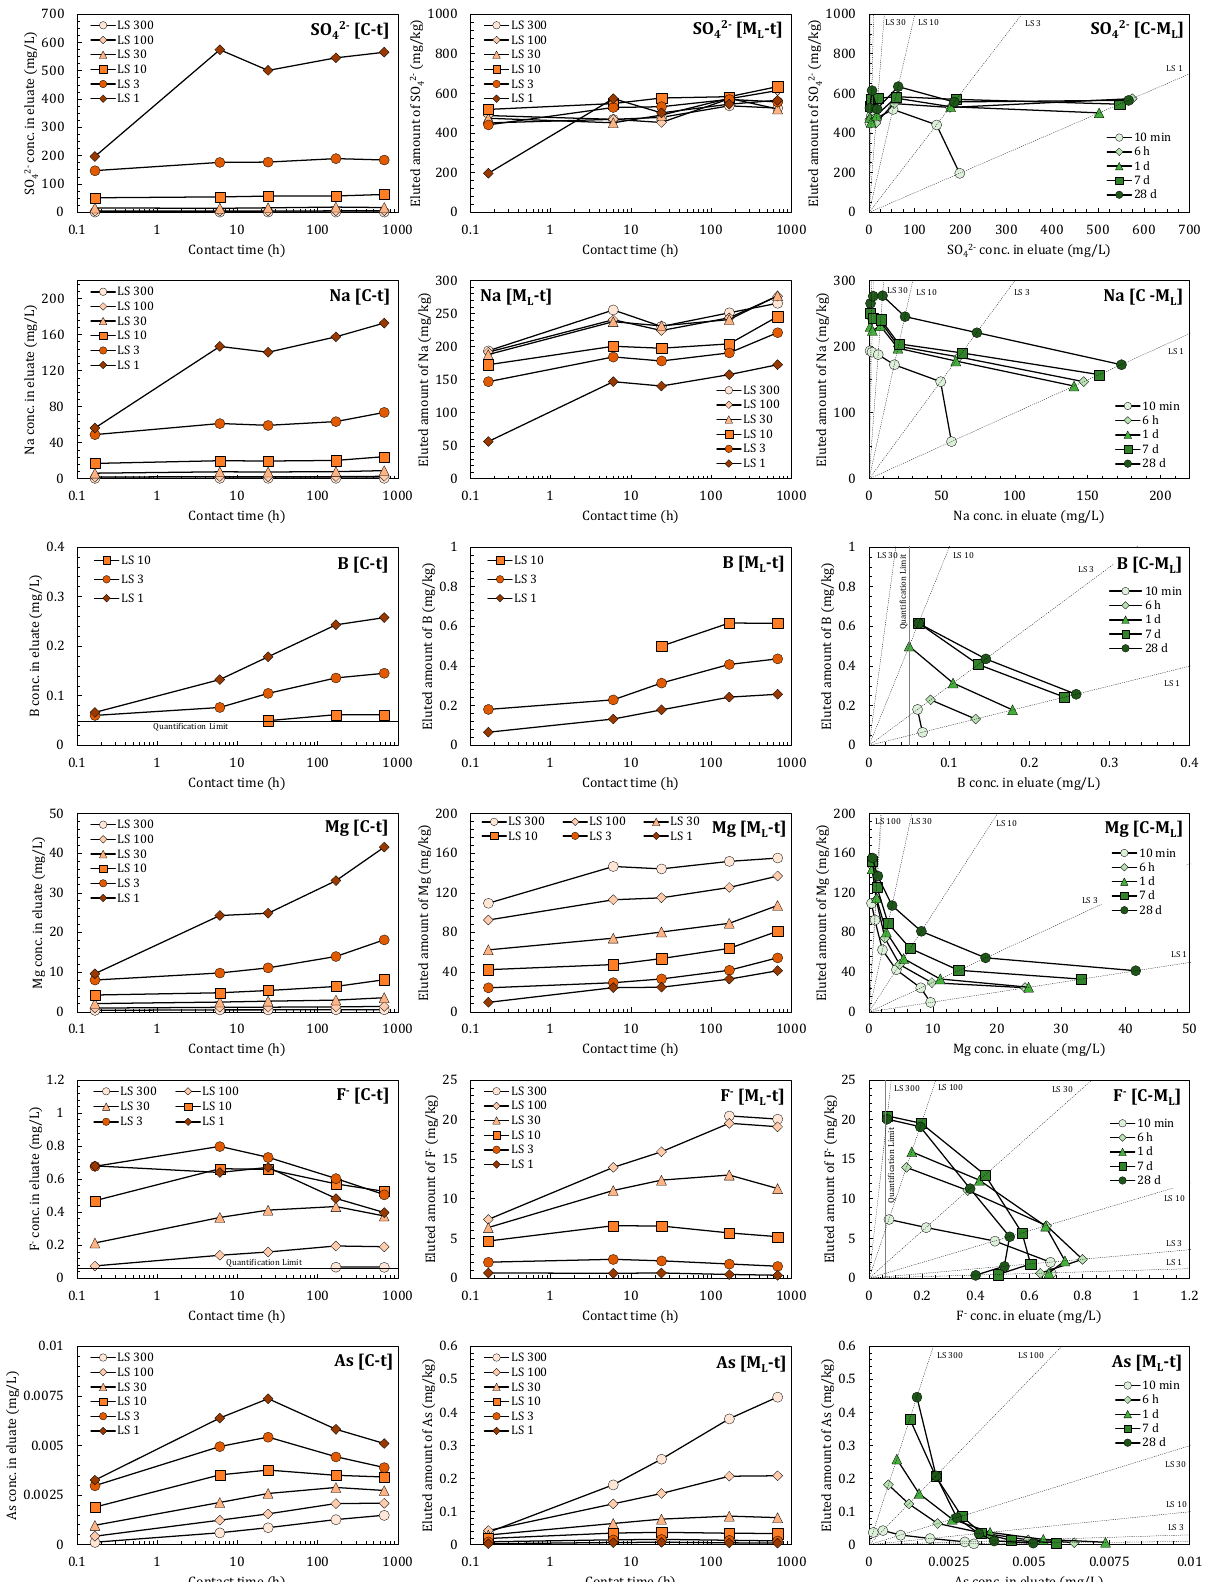
Figure 3. Changes in eluate concentration with time [ C-t ], changes in eluted amount with time [ M L -t ], and relationship between eluate concentration and eluted amount [ C-M L ]. In [ C-M L ] panels, data of the same LS batch condition are plotted on a straight-line passing through the origin. A lack of data means the eluate concentration was below the quantification limit.